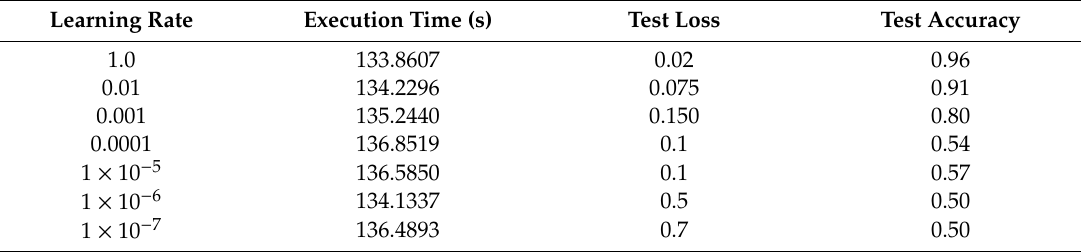
Table 21. Effect of momentum on SNN.